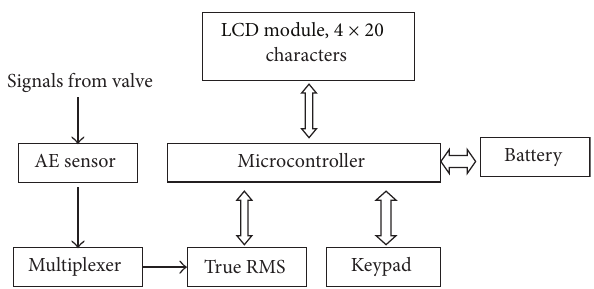
Figure 5: Block diagram of the system